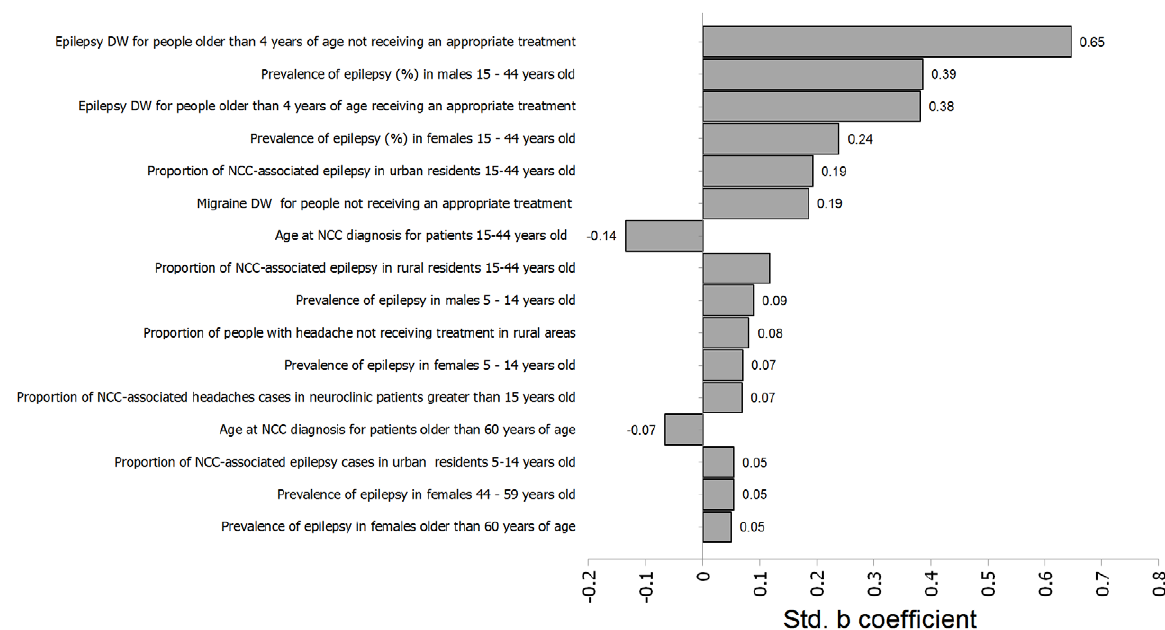
Figure 5. Sensitivity analysis of the total NCC-associated DALYs estimate for Mexico. Note: DW=Disability Weight.